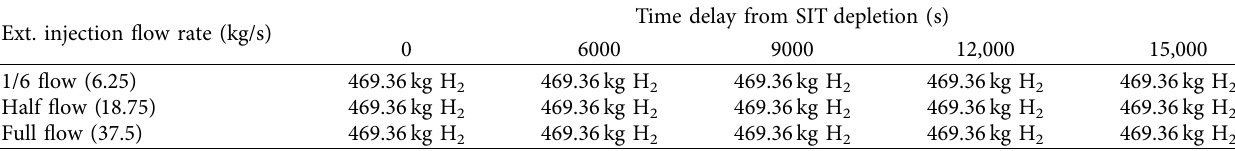
Table 10: Effect of external injection flow rate and time delay (depressurization at core melting).